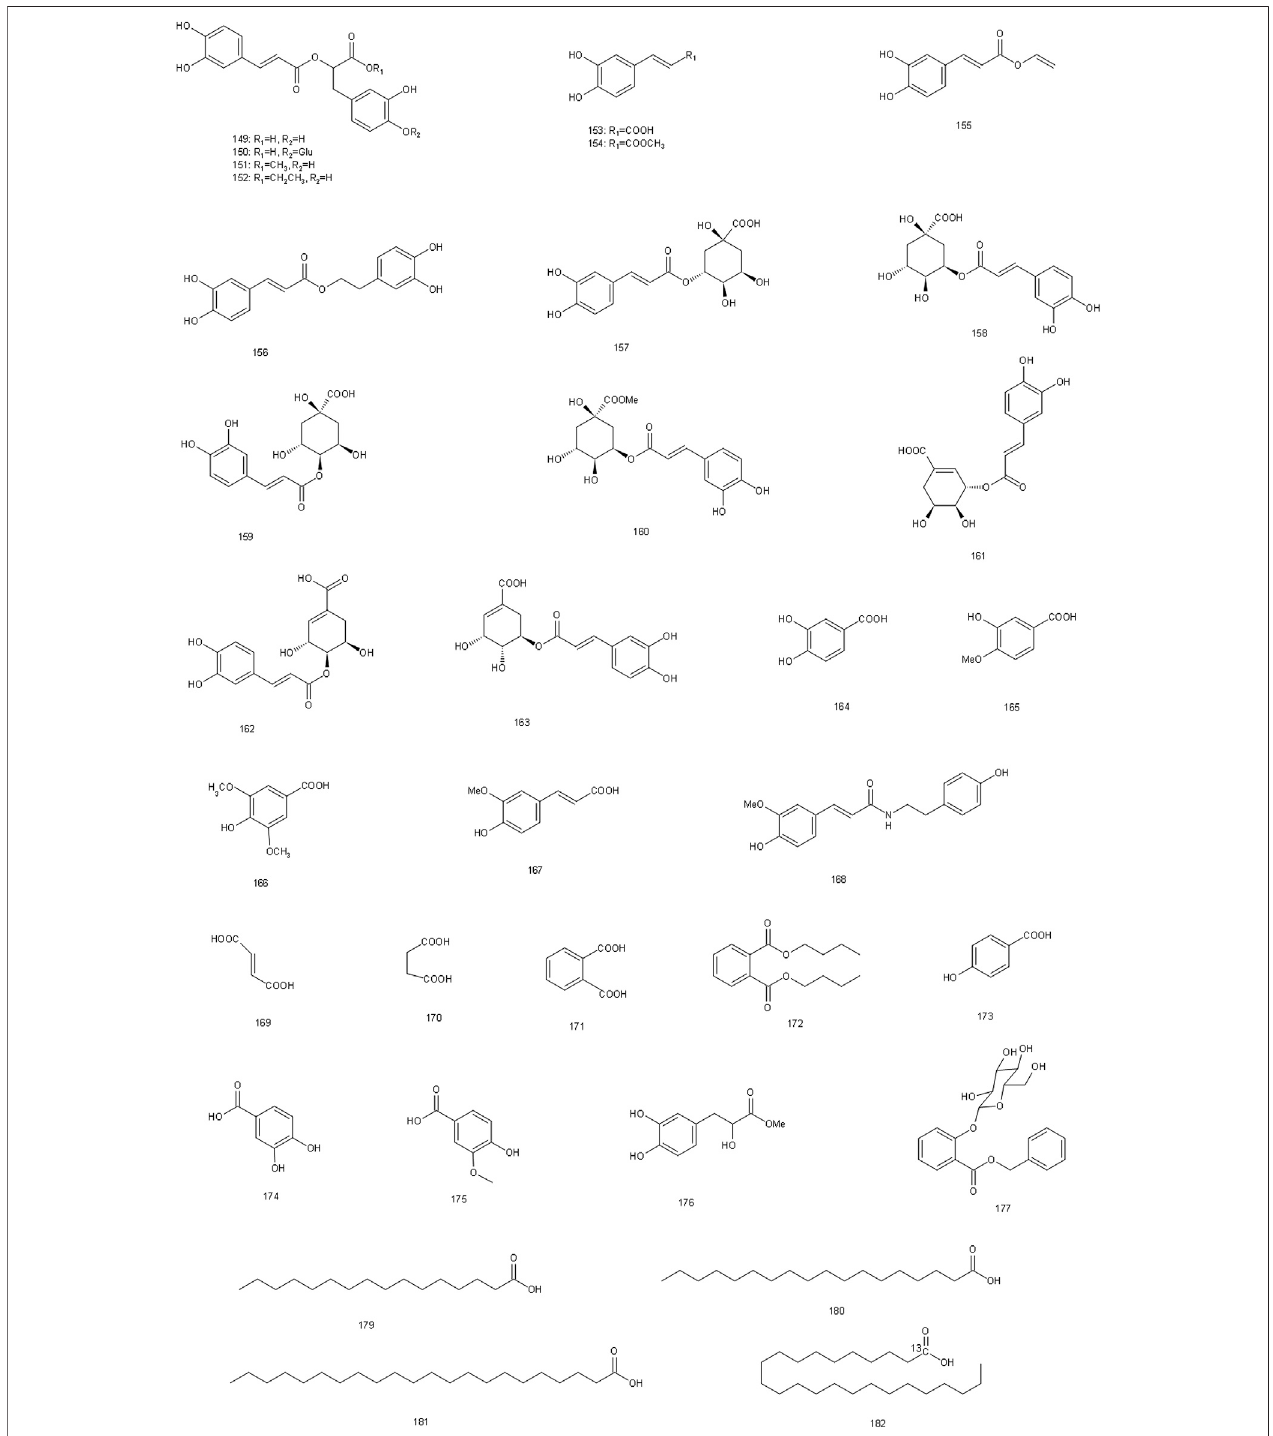
FIGURE 5 | Chemical structures of organic acids identi fi ed in S. glabra